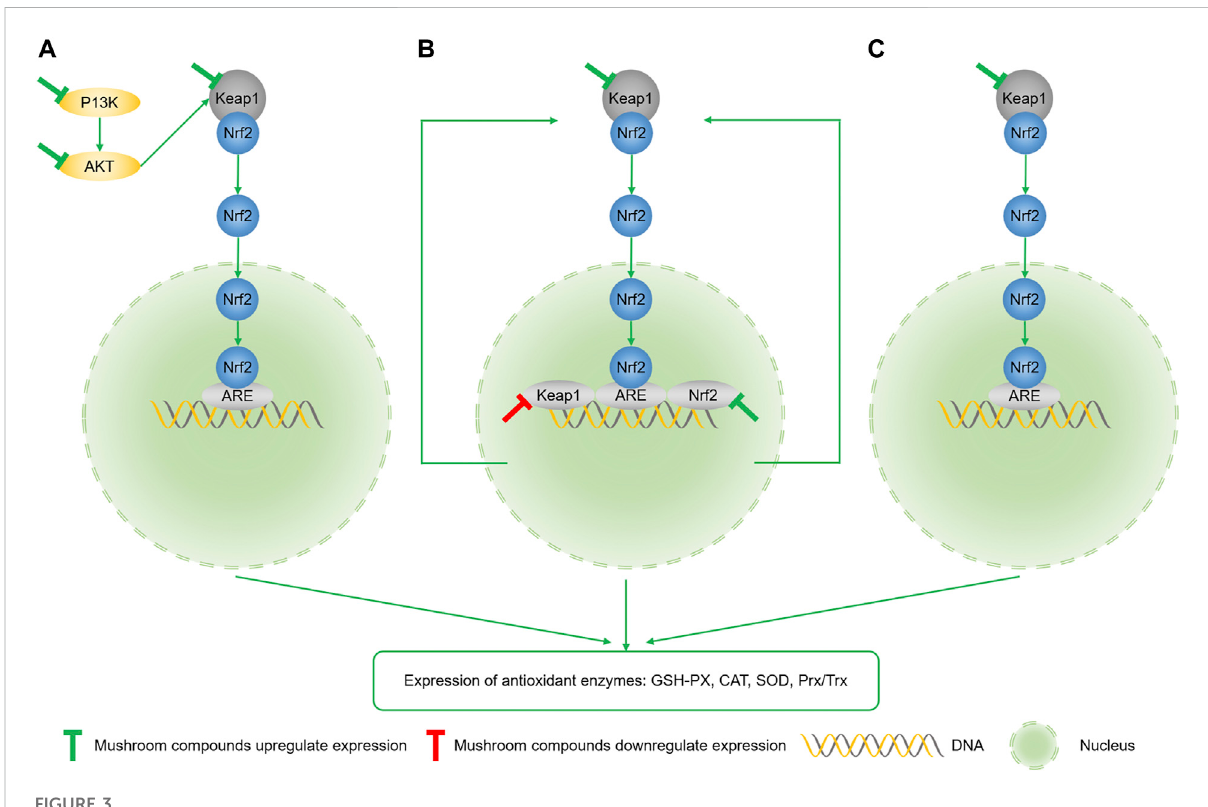
FIGURE 3 (A) Mushroom polysaccharides activate the Keap1/Nrf2/ARE pathway by upregulating the expression of P13K and AKT. (B) Mushroom peptides activate the Nrf2 pathway by downregulating the Keap1 gene and upregulating the Nrf2 gene expression. (C) Polyphenols directly promote the dissociation of Keap1 and